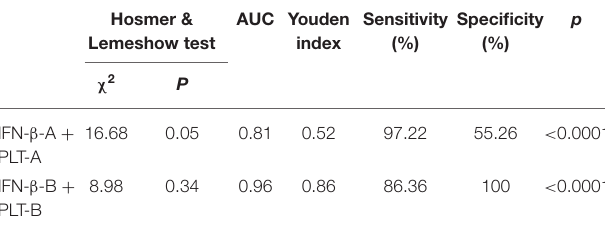
TABLE 4 | Comparison of IFN- β and PLT in the acute phase of KD (A), febrile control group (C), and healthy control group (D). The acute phase of